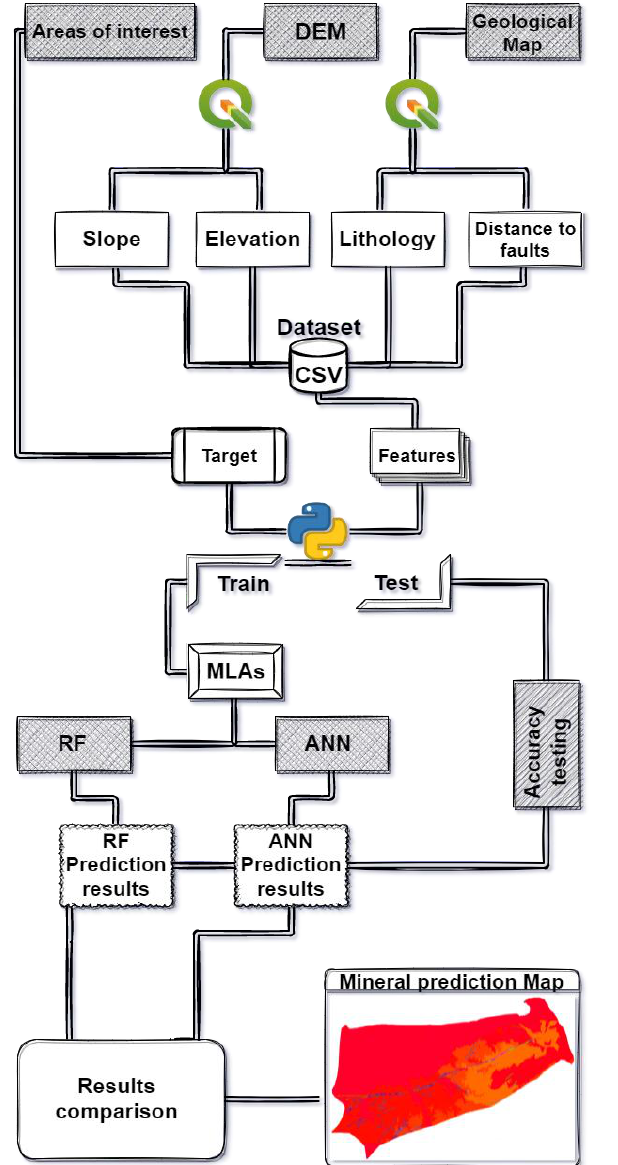
Figure 8: Workflow for Bou Skour mineral mapping based on GIS and machine learning. (Designed in: https://app.diagrams.net/)